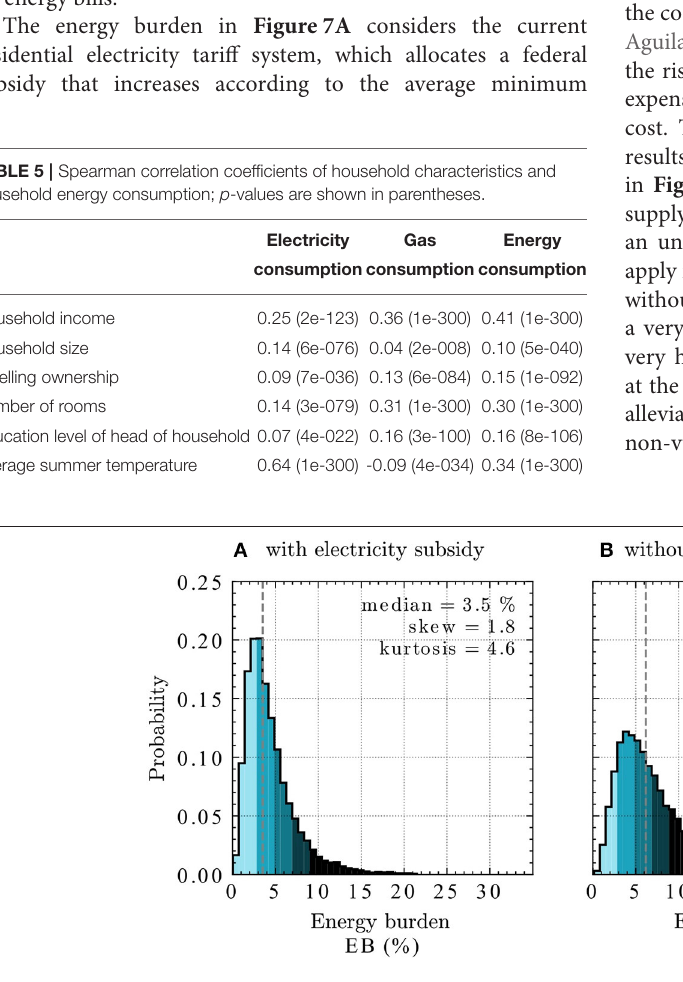
FIGURE 7 | Distribution of energy burden with (A) and without (B) electricity subsidy. Levels of energy burden are identified by color.